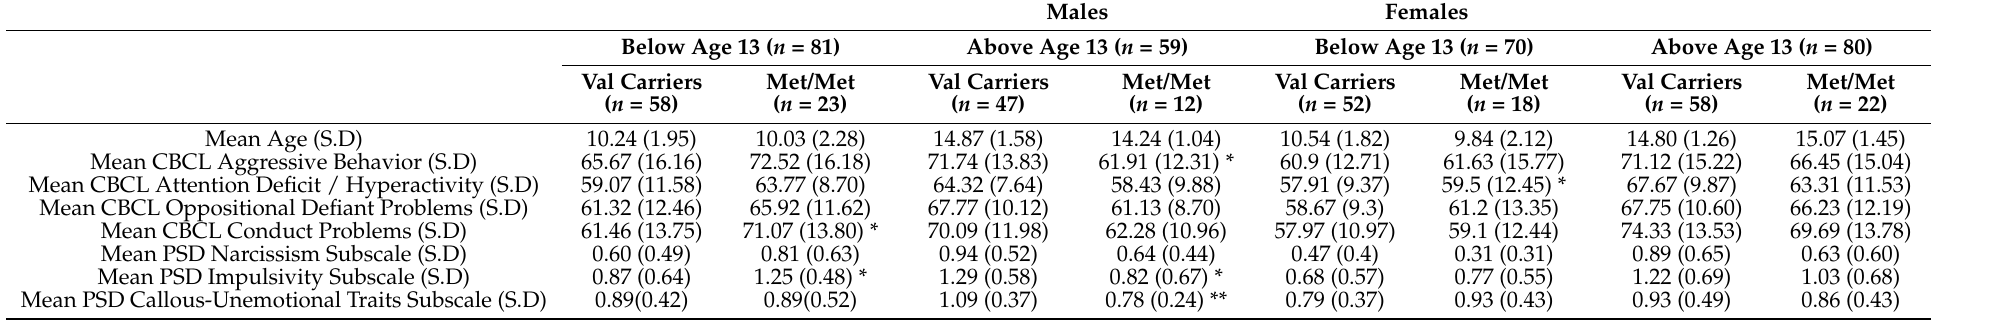
0.89(0.42) 0.86 (0.43) Note: * p < 0.05, ** p <